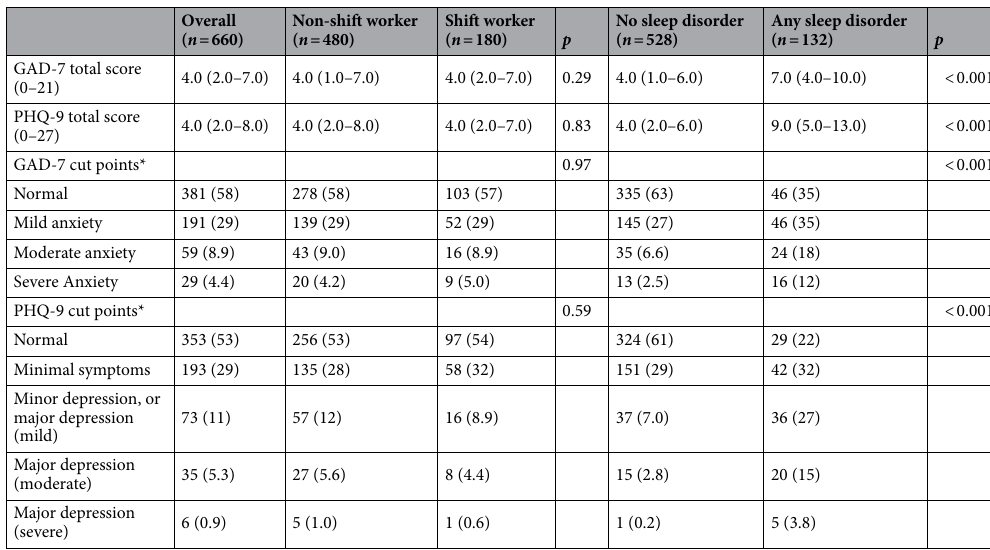
Table 2. Mental health outcomes by shift work and sleep disorder status. Data are median (IQR) or n (%) unless otherwise specified. Differences between shift work groups were determined using Pearson’s chi-squared test, Wilcoxon rank sum test, or Fisher’s exact test. GAD-7, generalised anxiety disorder (GAD)-7 anxiety scale; PHQ-9, patient health questionnaire (PHQ)-9 depression; *, cutpoints determined according to existing literature 25 .